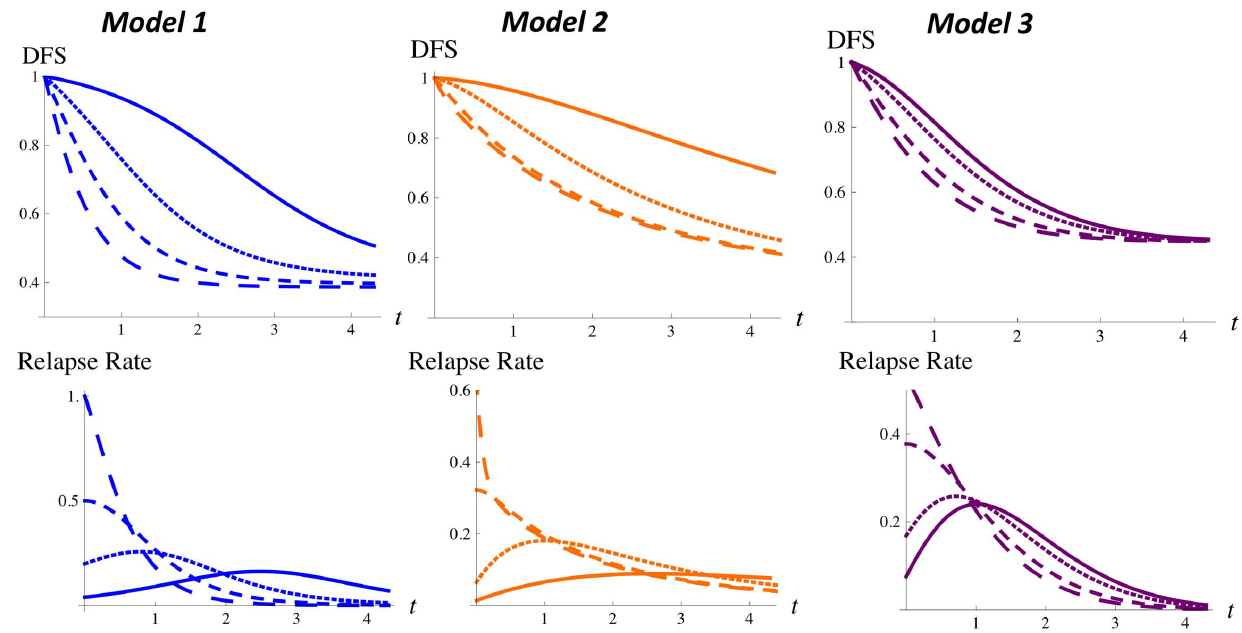
Figure 3. Peaks in the relapse rate. RFI curves (top) and corresponding relapse rates (bottom) for Models 1–3 as parameters k (Model 1)/ k V (Model 2)/ k 0 (Model 3) are reduced. In each plot, k / k V / k 0 decreases such that the ratio of the right-hand side to the left-hand side of the corresponding inequality determining whether there is a peak in the relapse rate is 2 (long-dashed line), 1 (short-dashed line), 1/5 (dotted line) and 1/ 25 (solid line).